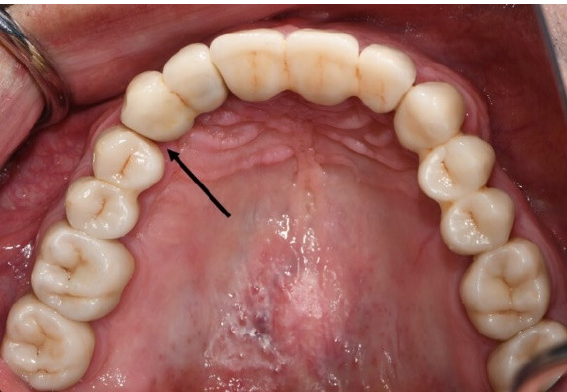
Figure 5. The arrow shows an open contact point between implant restoration and adjacent tooth that needs to be repaired because of impacted food .